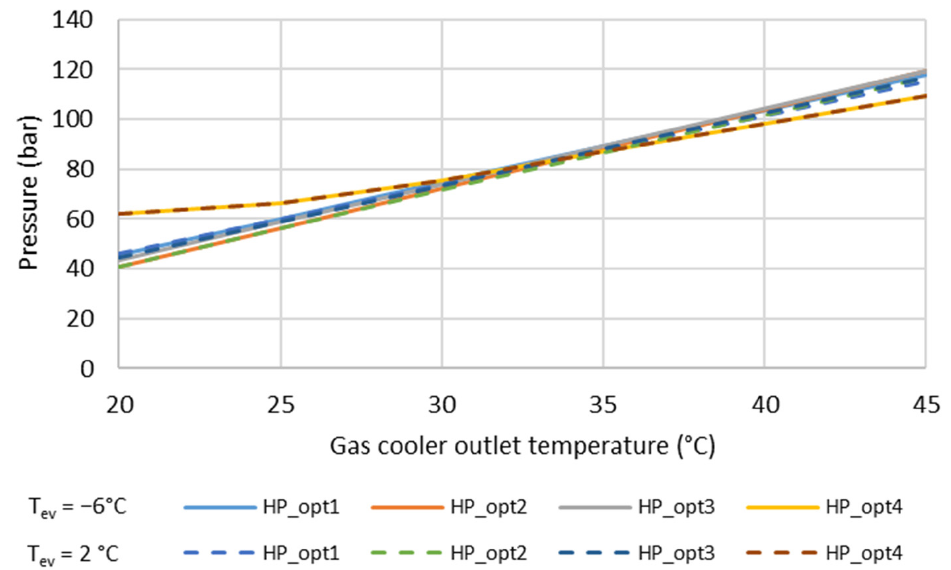
Figure 6. Comparison of optimal high pressures of the CO 2 transcritical cycle calculated by four correlations.